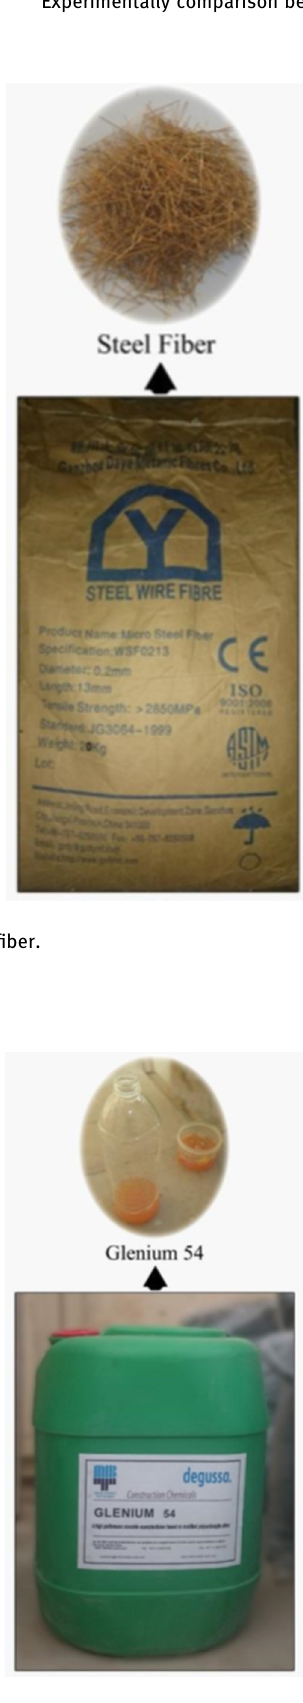
Figure 3: Glenium.